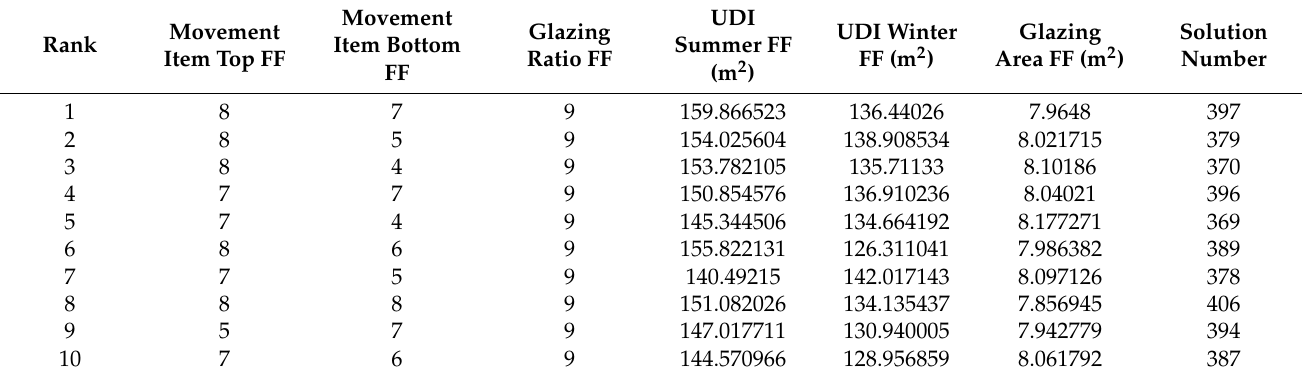
Figure 15. Scatterplot between two objectives and the Pareto front position; ( a ) UDI summer and UDI winter; ( b ) UDI summer and glazing area; ( c ) UDI winter and glazing area. To ease the observation of the individual distribution within the population fields Table 5. The 10 best design solutions, attributes, and (3D scatterplots), 2D scatterplots have been incorporated. Figure 15 depicts scatterplots